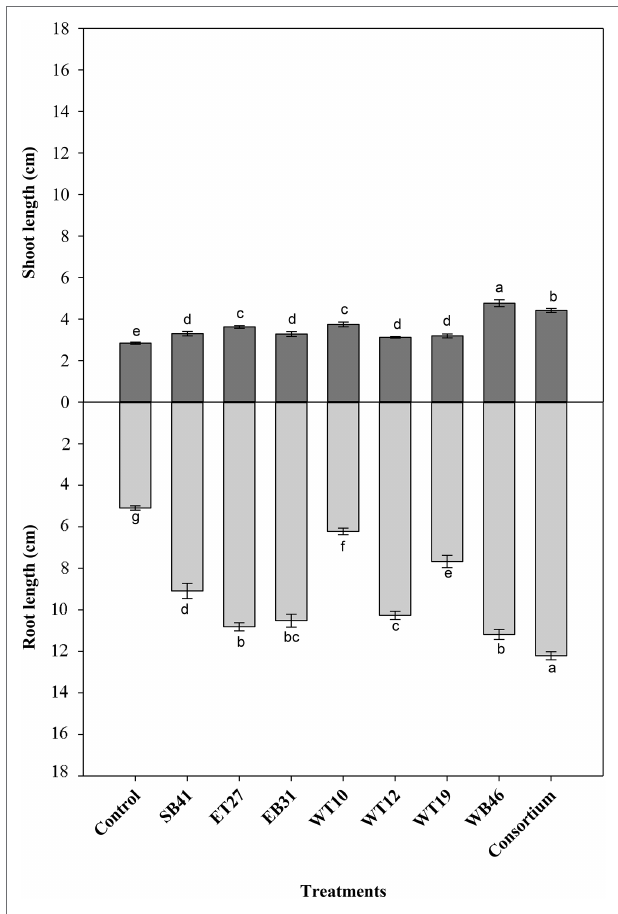
FIGURE 6 | Effect of selected PGPR bacterial strains on root and shoot length (cm) of canola plants measured after 7 days of growth in the presence of 3% n -hexadecane. Error bars represent SDs, and different letters indicate significance according to Tukey’s post-hoc test at p ≤